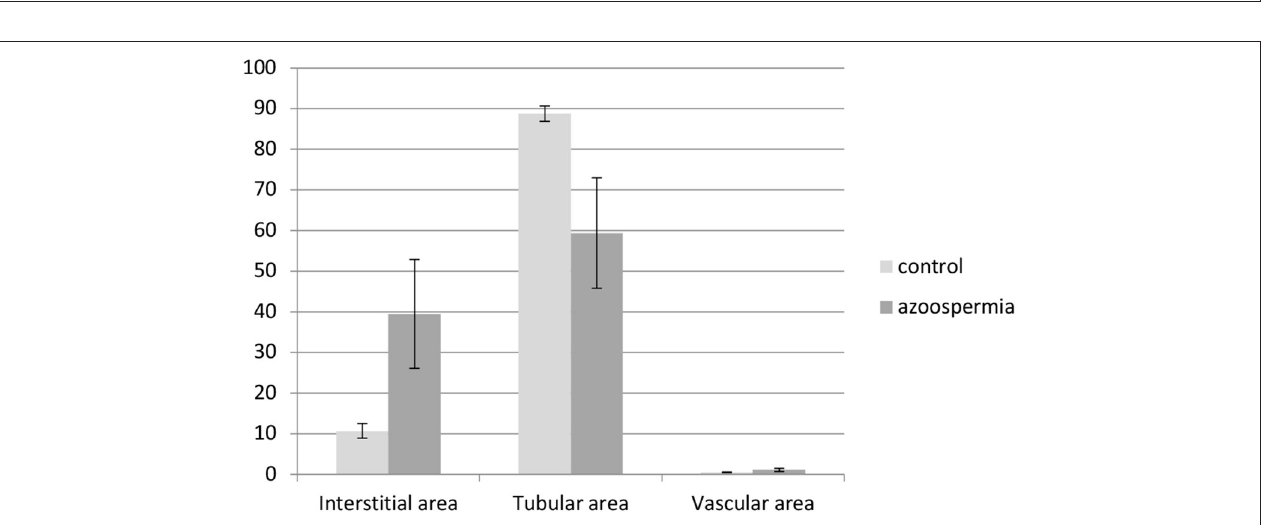
FIGURE 3 | Hematoxylin–eosin-stained testicular tissue [ (A,B) 200 × magnification; (C,D) 4007 magnification]: (A) Tubular shadows, tubules containing neither germ nor Sertoli cells, and basal membrane is very thickened ( black cross ), (B) late arrest with fibrosis thickened basal membrane ( black arrow ), (C) Sertoli-cell-only syndrome ( black star ) with vacuoles ( dotted arrow ), and (D) early arrest with thickened basal membrane ( black arrow ) and multinucleated germ cells ( dotted circle ).